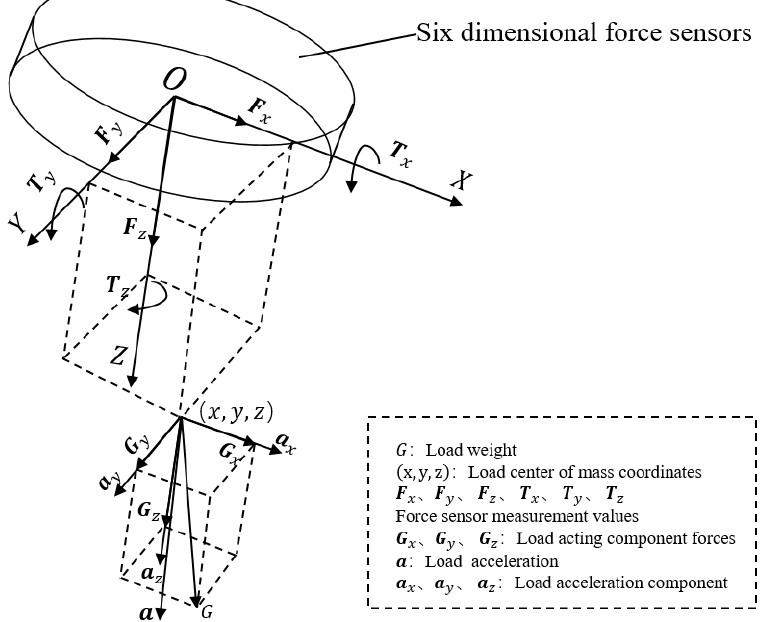
Figure 1. Diagram of gravity